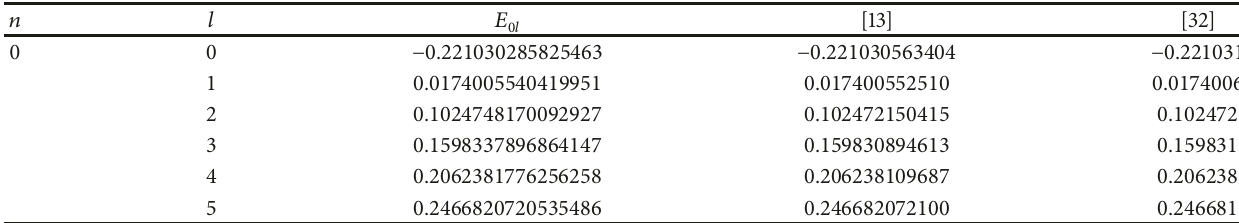
Table 4: Comparison of eigenvalues of 𝑉(𝑟) = −1/𝑟 + 0.01𝑟 for 𝑙 states.